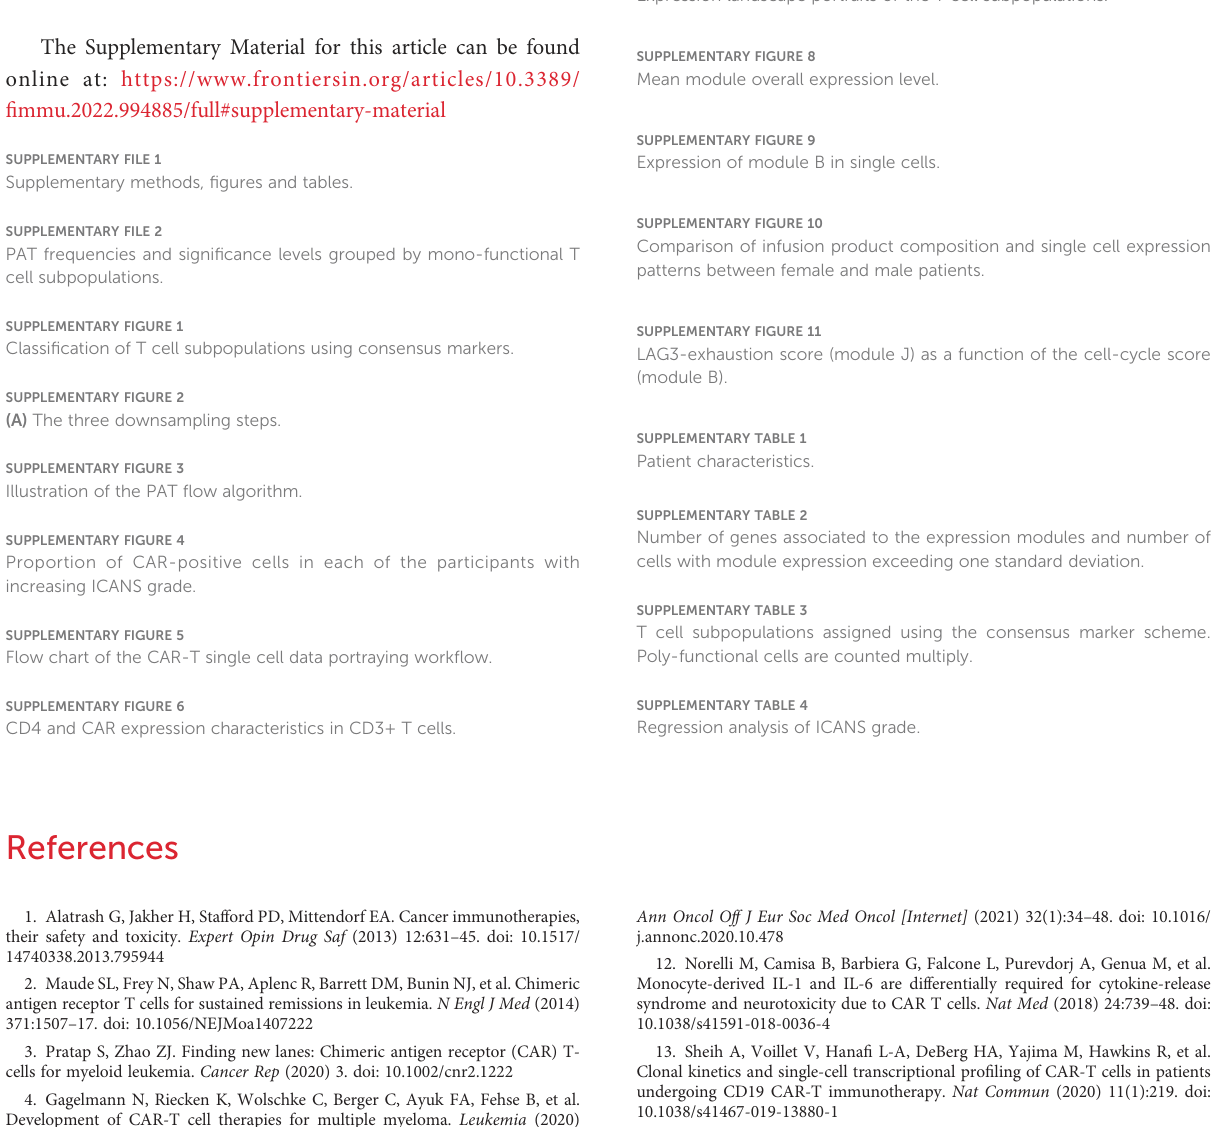
SUPPLEMENTARY FIGURE 7 Expression landscape portraits of the T cell subpopulations.